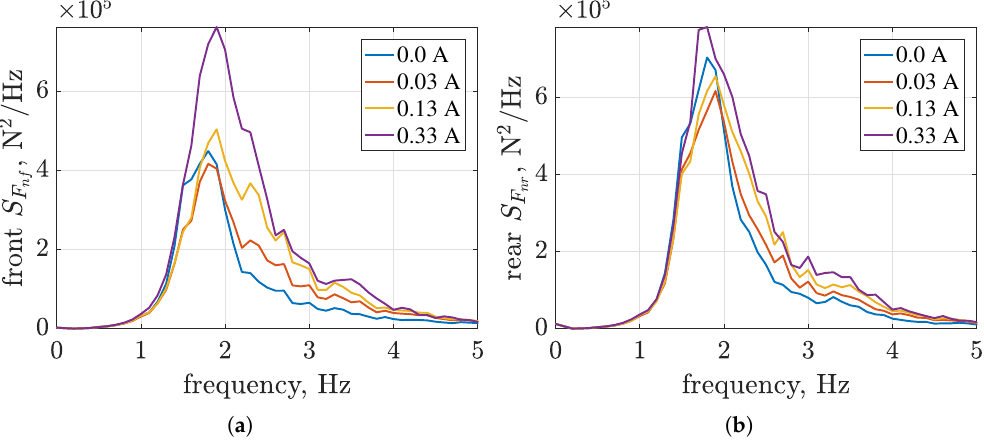
Figure 12. Power spectral density characteristics of wheel normal forces for passive suspension and the vehicle constant longitudinal velocity 5 ms − 1 : ( a ) front wheel, ( b ) rear